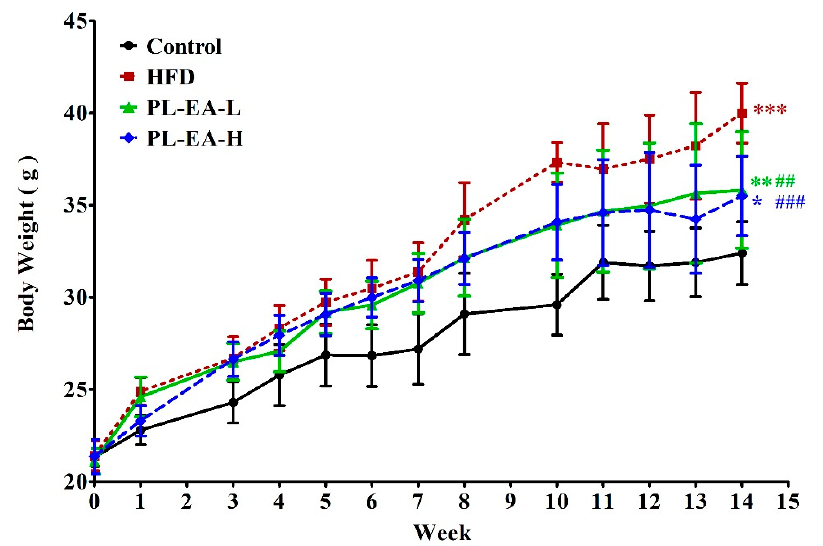
Figure 3. PL-EA inhibits high-fat high-fructose (HFD)-induced obese in mice. HFD: high-fat/high- fructose diet. PL-EA-H: HDF + high dose PL-EA (70 mg/kg). PL-EA-L: HDF + low dose PL-EA (35 mg/kg). Data are expressed as mean ± SE ( n = 9). ## p <0.01; ### p < 0.001 vs. the HFD group; * p < 0.05; ** p < 0.01; *** p < 0.001 vs. the control.